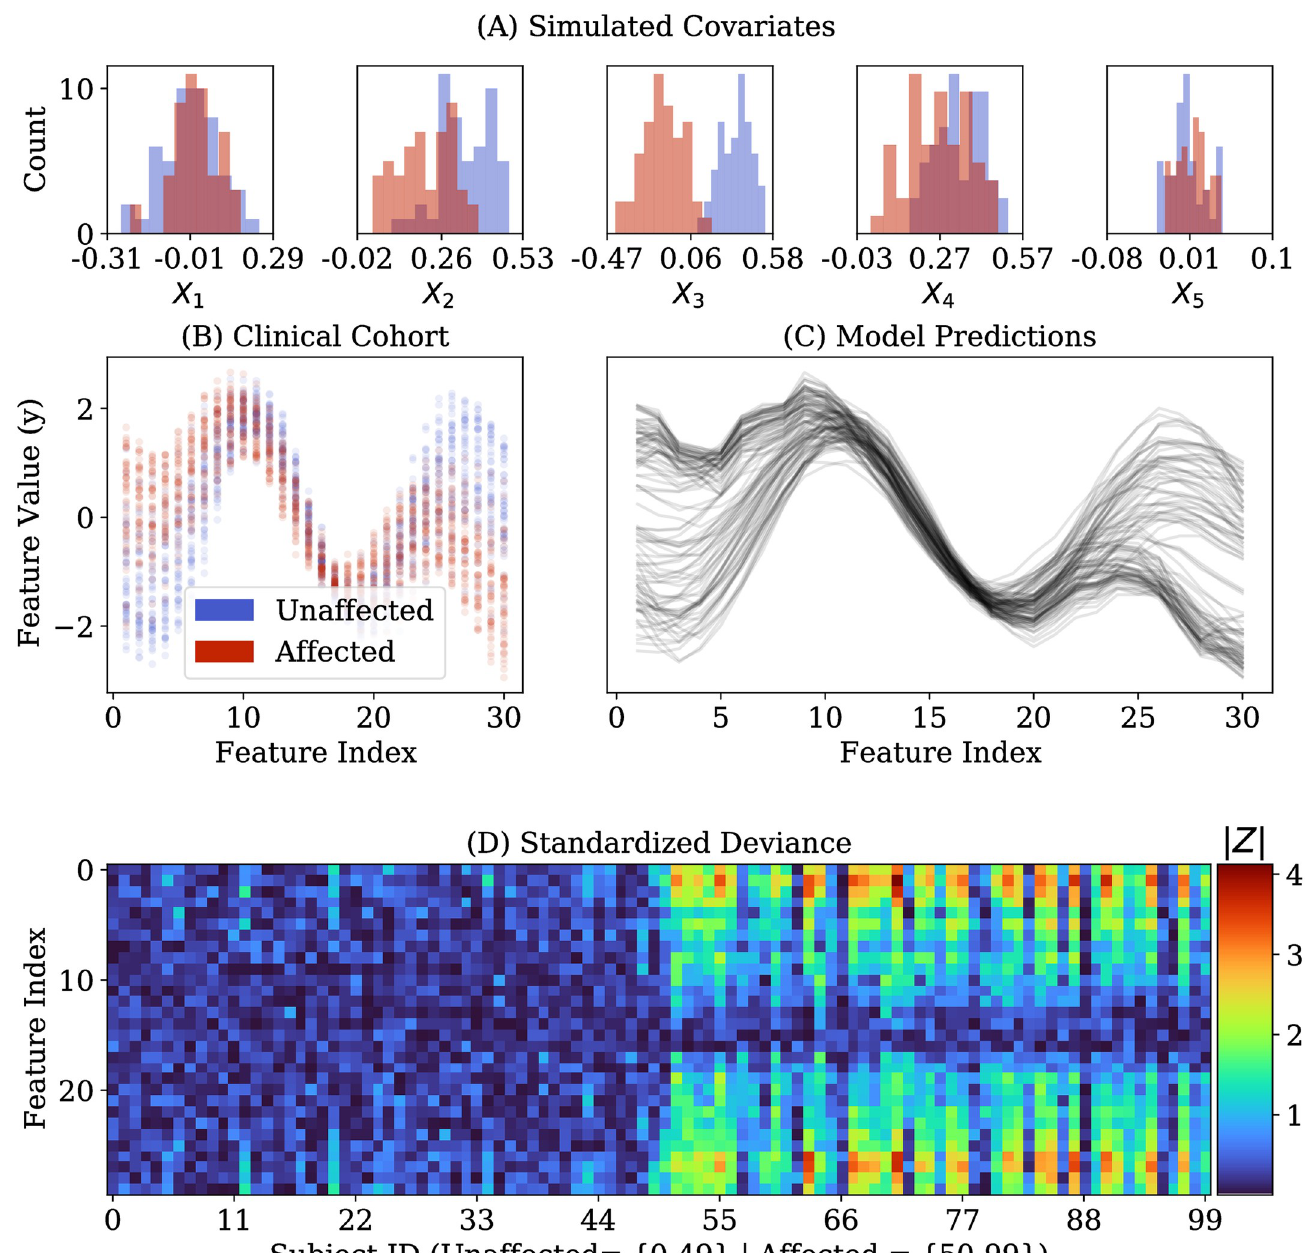
Fig 2. Application of normative model to independent cohorts from synthetic normative and clinical distributions. Panel A : Simulated covariates for N 0 = 100 subjects in a clinical cohort (50 “affected” and 50 “unaffected”). Panel B : Plot of the M = 30 response variables. Panel C : Predictions of a normative model trained on the normative cohort data. Panel D : Standardized deviance (Eq 1) of each subject, at each of the 30 features.